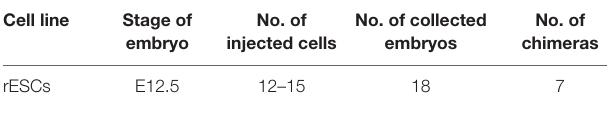
TABLE 3 | rESCs contributed to chimeras by injection to